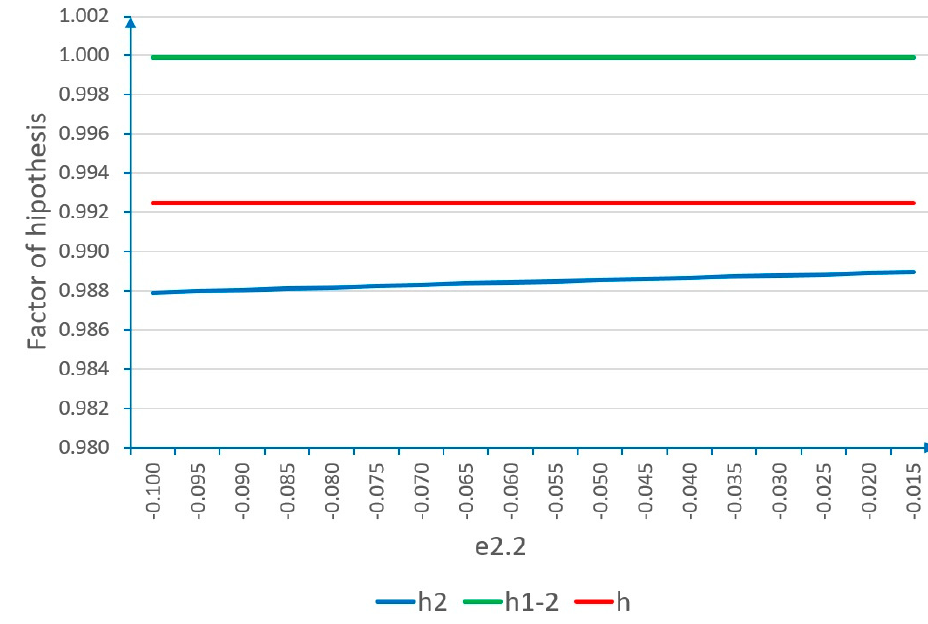
Figure 12. The result of the CQoPS simulation and indirect hypotheses in the e2.2 factor function. The result of the operation of software written by one of the authors of the article.